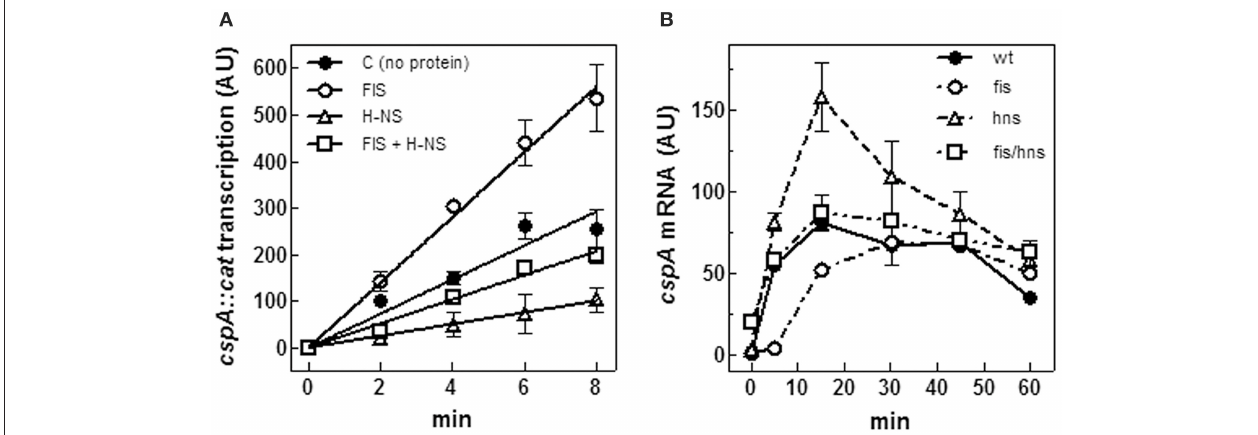
FIGURE 5 | FIS and H-NS modulate cspA transcription. (A) In vitro transcription assay programmed with pKK cspA310::cat. DNA template was pre-incubated at 37 ◦ C in the absence of proteins ( (cid:8) ), with 50nM FIS ( (cid:13) ), 375nM H-NS ( 1 ) and with both FIS (50nM) and H-NS (375nM) ( (cid:3) ) as dimers. The reaction was started by adding 0.15 units of RNA polymerase and the incubation was prolonged for the indicated times at 37 ◦ C, as described in Materials and Methods. (B) Steady-state levels of CspA mRNA were determined in wt E. coli cells ( (cid:8) ), a fis null allele ( (cid:13) ), an hns null allele ( 1 ), and a double mutant fis-hns ( (cid:3) ). After a 10-fold dilution with fresh medium of saturated cultures grown in LB at 37 ◦ C, total RNA was extracted at the indicated times and subjected (10 µ g) to Northern analysis. The radioactivity associated with cspA mRNA, normalized for the corresponding amounts of 16S rRNA, was quantified by Molecular Imager (Bio-Rad) and expressed as Arbitrary Units (AU). Data represent the average of at least two independent experiments and standard deviation is